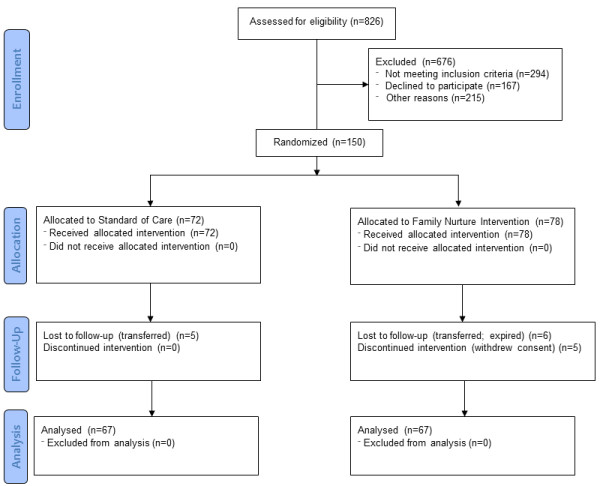
Study consort chart.